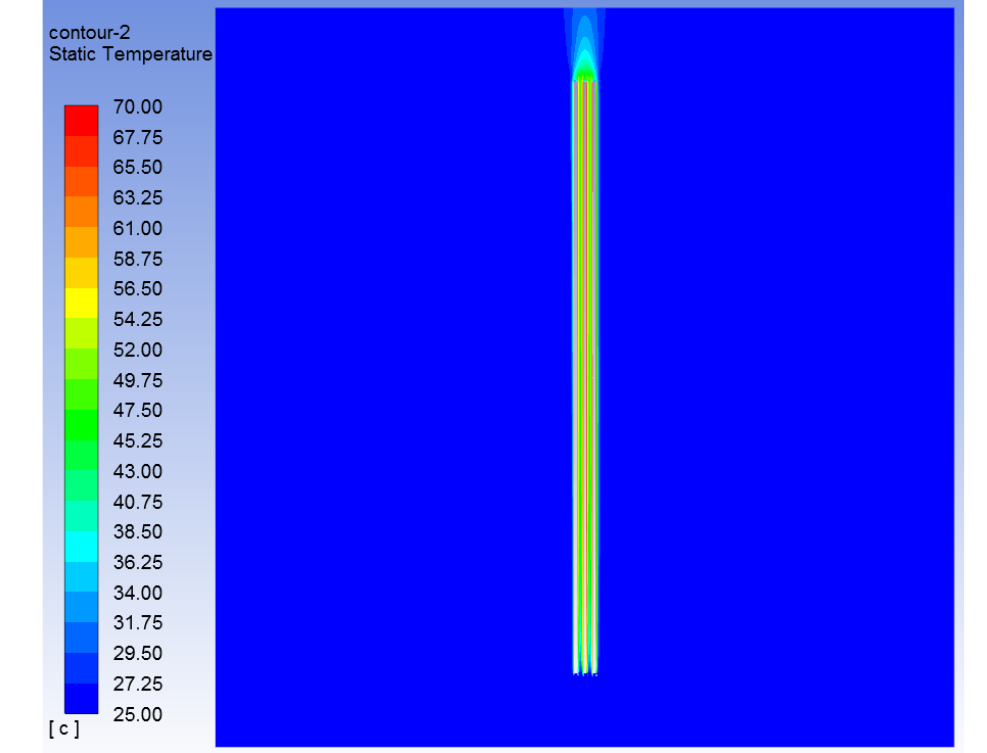
Figure 4. Temperature distribution around power cables (max permissible load: I ZL1 = I ZL2 = I ZL3 = 152 A) without solar radiation.